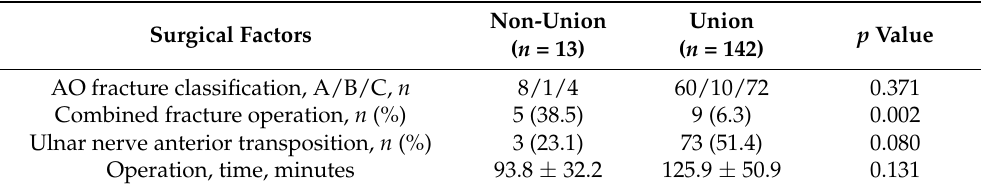
Table 3. Comparison of surgical factors between non-union patients and union patients.